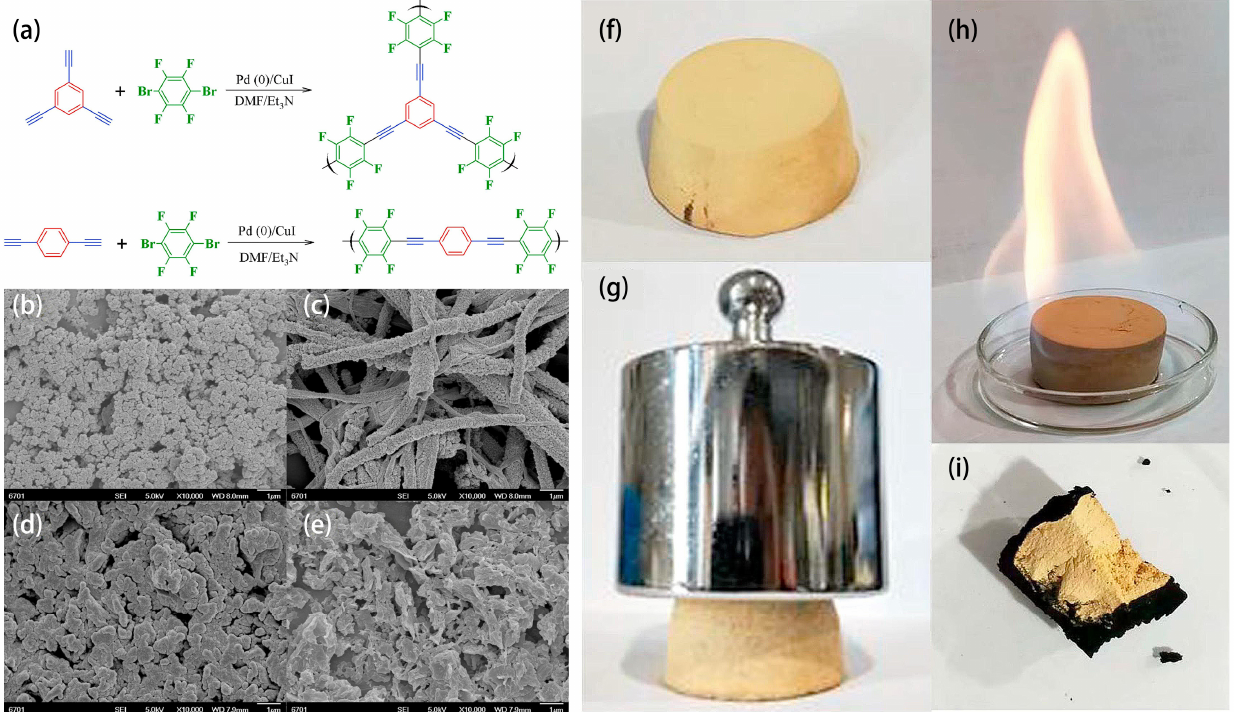
Figure 6. Two flame − retardant coating materials (FCMP-1 and FCMP-2) prepared through Sonogashira–Hagihara coupling ( a ) synthesis route and the morphologies of FCMP-1 and FCMP-2 after soaking in toluene or DMF ( b ) FCMP-1 in toluene, ( c ) FCMP-1 in DMF, ( d ) FCMP-2 in toluene, or ( e ) FCMP-2 in DMF. ( f ) Image of foam coated with FCMP-1 and ( g ) the same foam under 500 g weigh. ( h , i ) Image of the foam soaked with ethanol under burning and the residue after burning. Reprinted with permission from Ref. [88]. Copyright 2018 Elsevier.